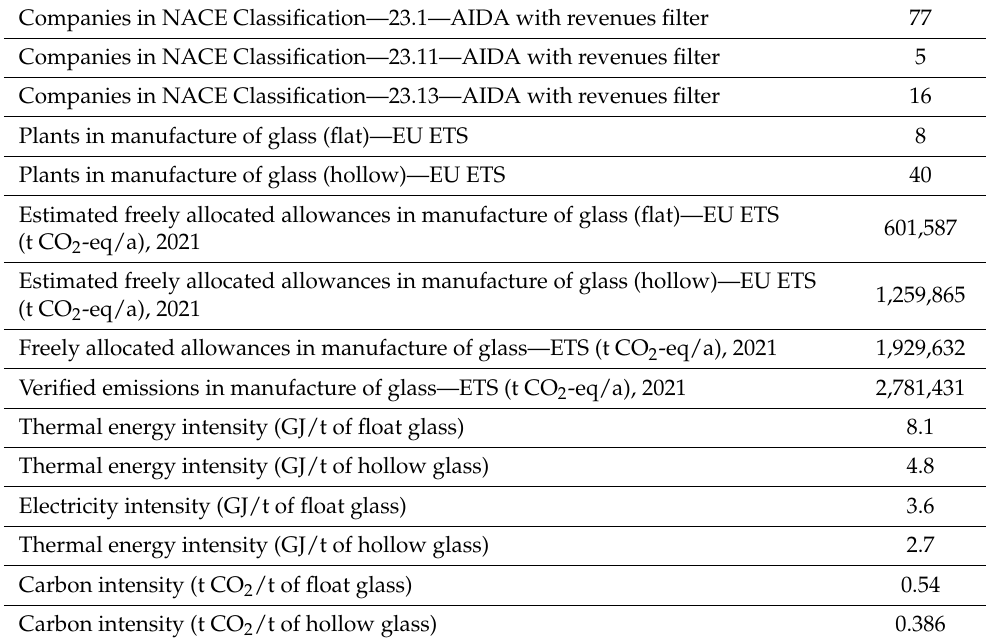
Table 4. Summary data for glass production plants in Italy under EU